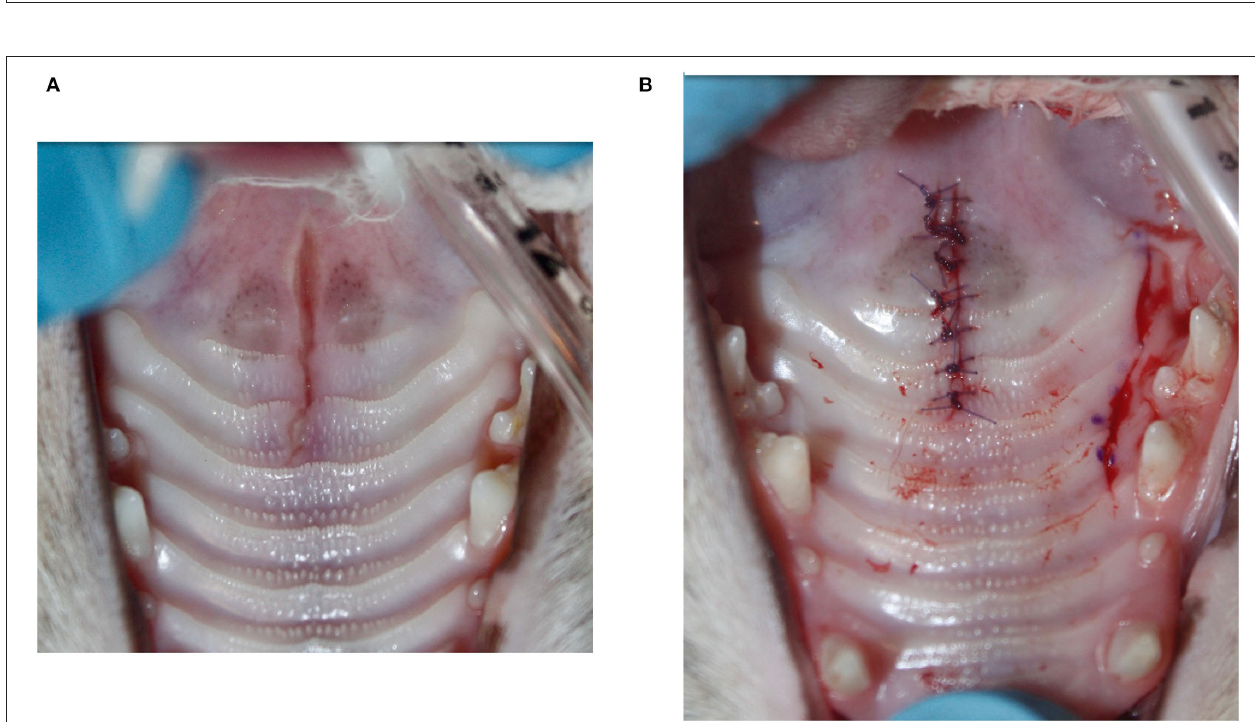
FIGURE 3 | Unilateral pedicle flap technique with lateral releasing incision. (A) Narrow acquired midline palate defect (PDE) from the level of the maxillary fourth premolar teeth to the rostral aspect of the soft palate. The widest area is located at the transition of the hard and soft palate. (B) The unilateral releasing incision was made about 2-mm palatal to the teeth and did not extend into the soft palate. After elevation of the mucoperiosteal flap between the defect and the lateral incision, the PDE was sutured closed in a simple interrupted pattern.